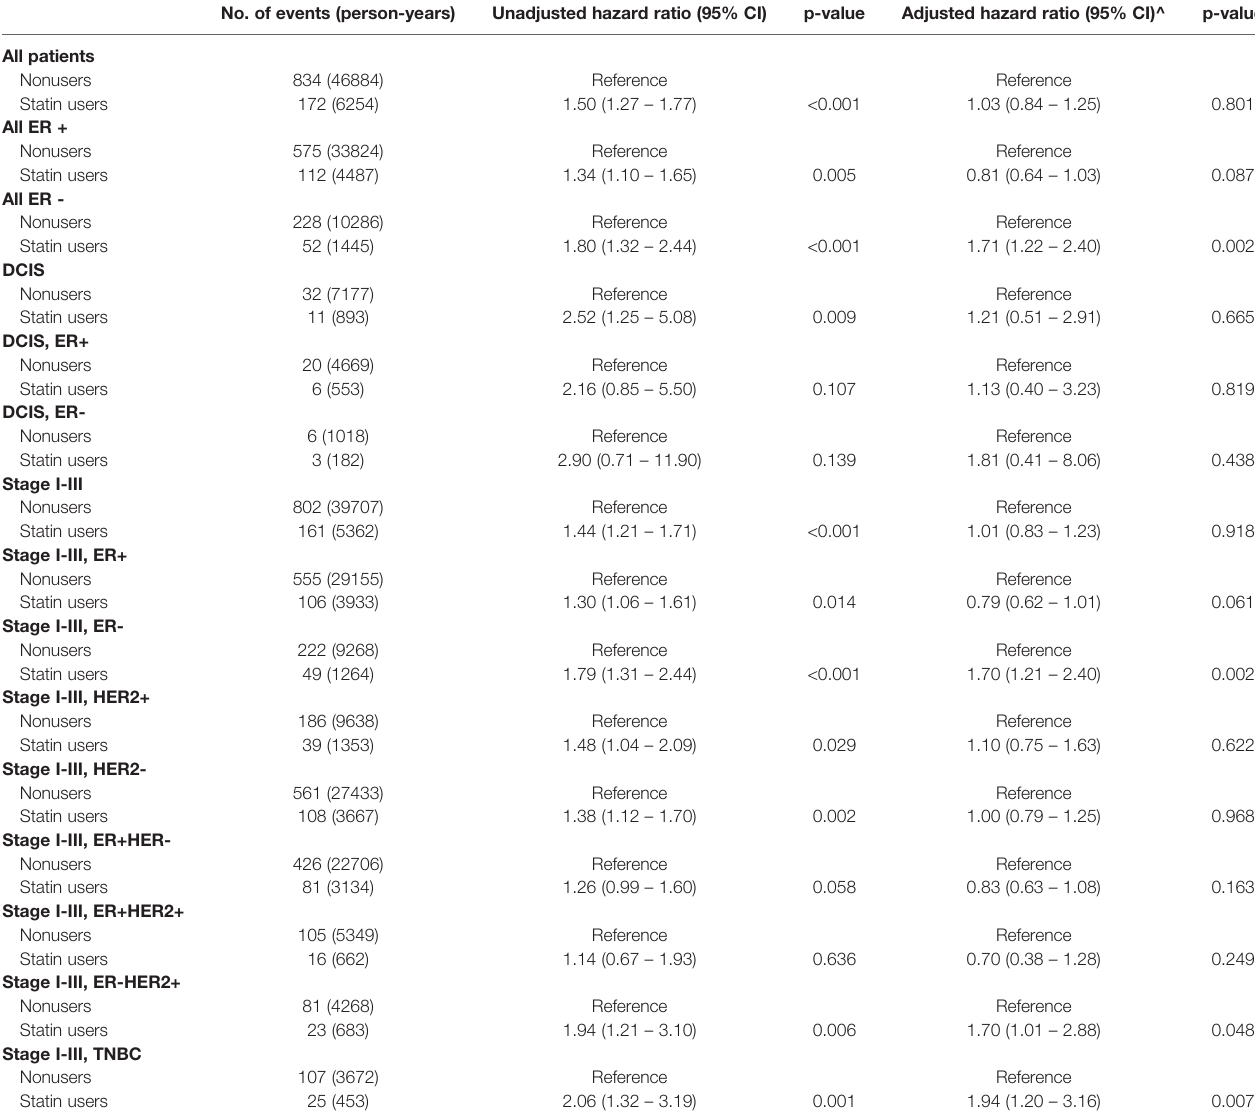
TABLE 4 | Unadjusted and adjusted hazard ratios for overall survival by statin use in different subsets of patients. No. of events